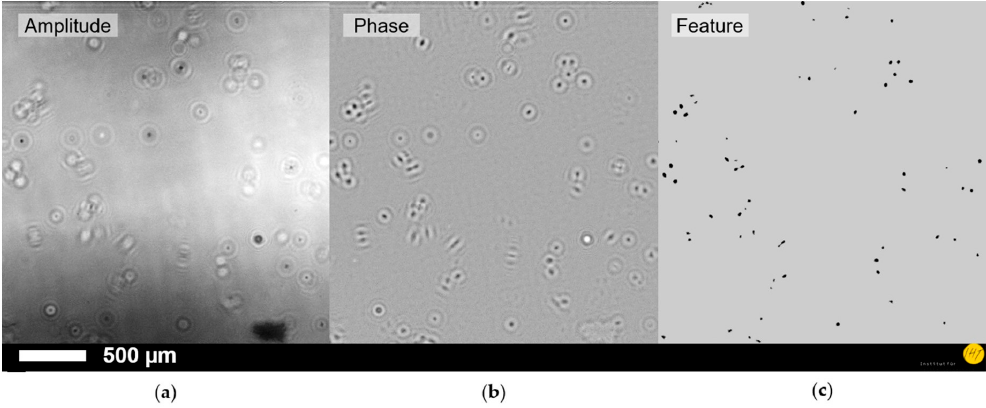
Figure 2. Microscopic images of immortalized mouse astrocytes during cell culture process: ( a ) amplitude image, ( b ) phase contrast image, and ( c ) processed data for cell counting with marks indicating the detected cell positions.